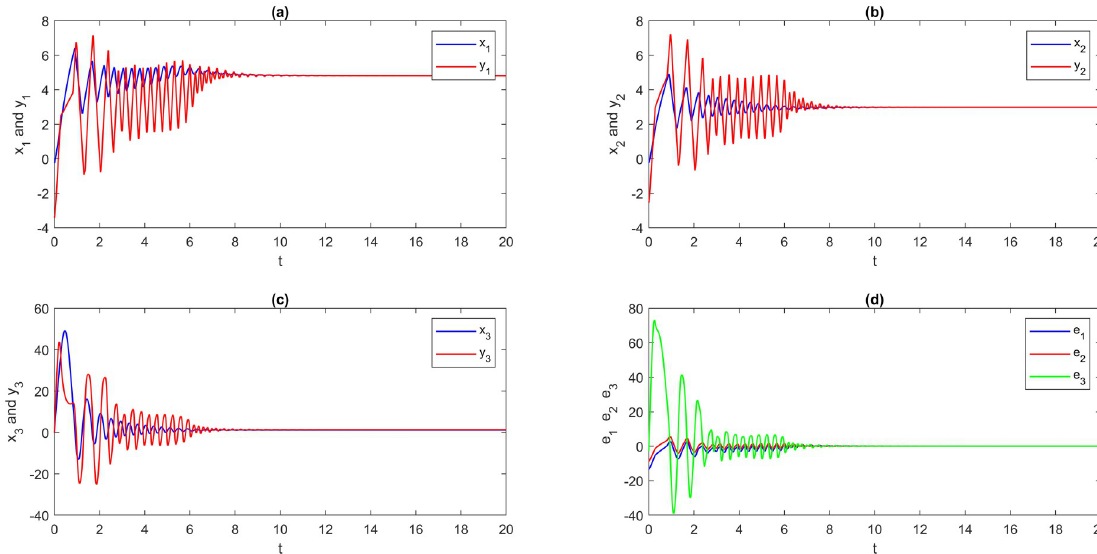
Fig 4. Multi-time delay of multi-FONNSMD synchronization with controller activation. (a) x 1 versus y 1 , (b) x 2 versus y 2 , (c) x 3 versus y 3 , and (d) Synchronization error. https://doi.org/10.1371/journal.pone.0270402.g004 Based on Examples 1–3, Table 2 encloses various results of dynamic synchronization error values for different values of parameters of multi fractional-order in the system (24) and sys- tem (25). At this point, experiments are conducted with multi-time delay, multi time-varying delays and without delay. As seen in Table 2, as time increases, the dynamic synchronization ; S , and S converge to zero. All the examples of dynamic errors show errors of S t ð Þ t ð Þ t ð Þ 1 2 3 E E E the same performance. Initially, the error value reduces, and after some time, it increases